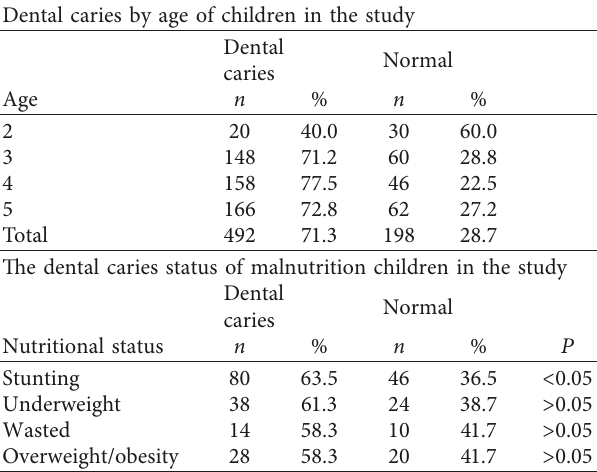
Table 4: Dental caries of children in the study. Table 5: Parent’s care about the dental issue of